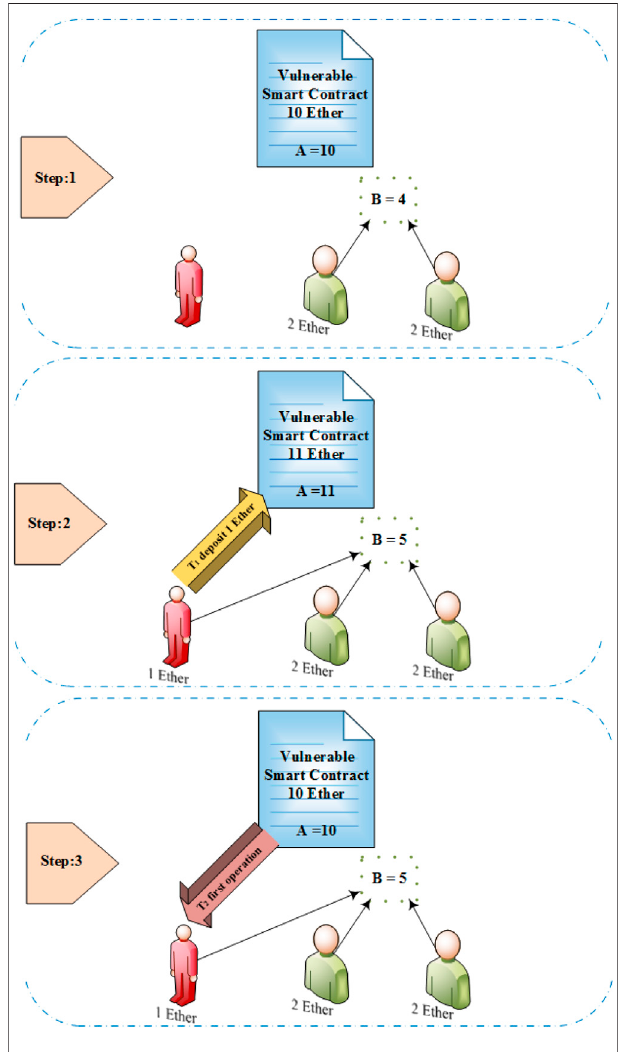
FIGURE 1 | Reentrancy attack